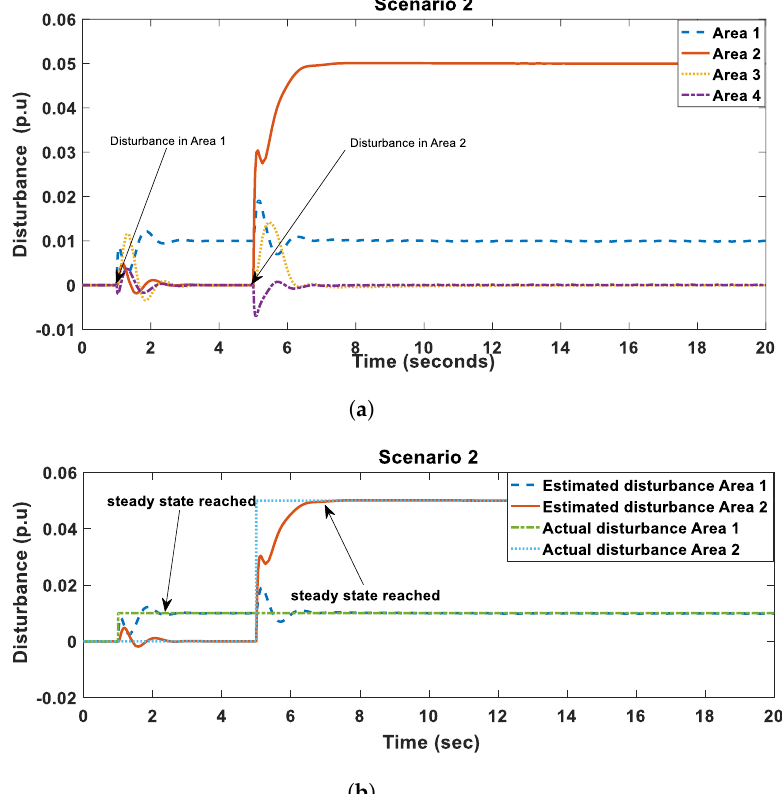
Figure 9. Scenario 2: ( a ) estimated disturbances and ( b ) actual vs. estimated